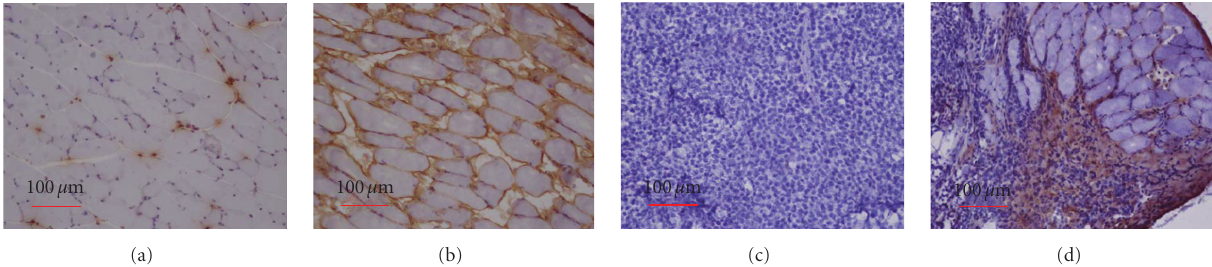
Figure 4: Immunohistochemistry of avidin (a,c) or OXavidin (b,d) injected normal muscle (a,b) or MDA-MB-468 human breast carcinoma xenotransplanted mass (c,d) 48 hours after injection.